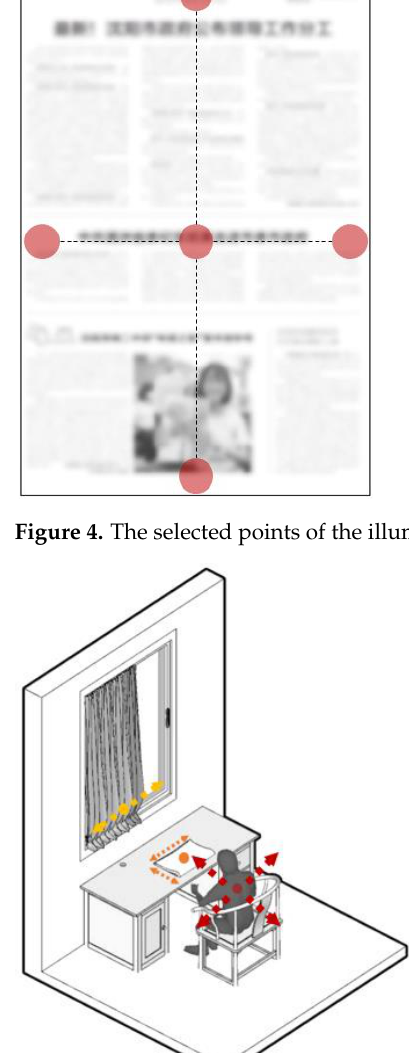
Figure 6. Instruments. ( a ) Human – machine environment synchronization experiment platform. ( b ) EDA modules. ( b ) EDA modules. ( c ) Physiological sensing kit. ( d ) Wearing